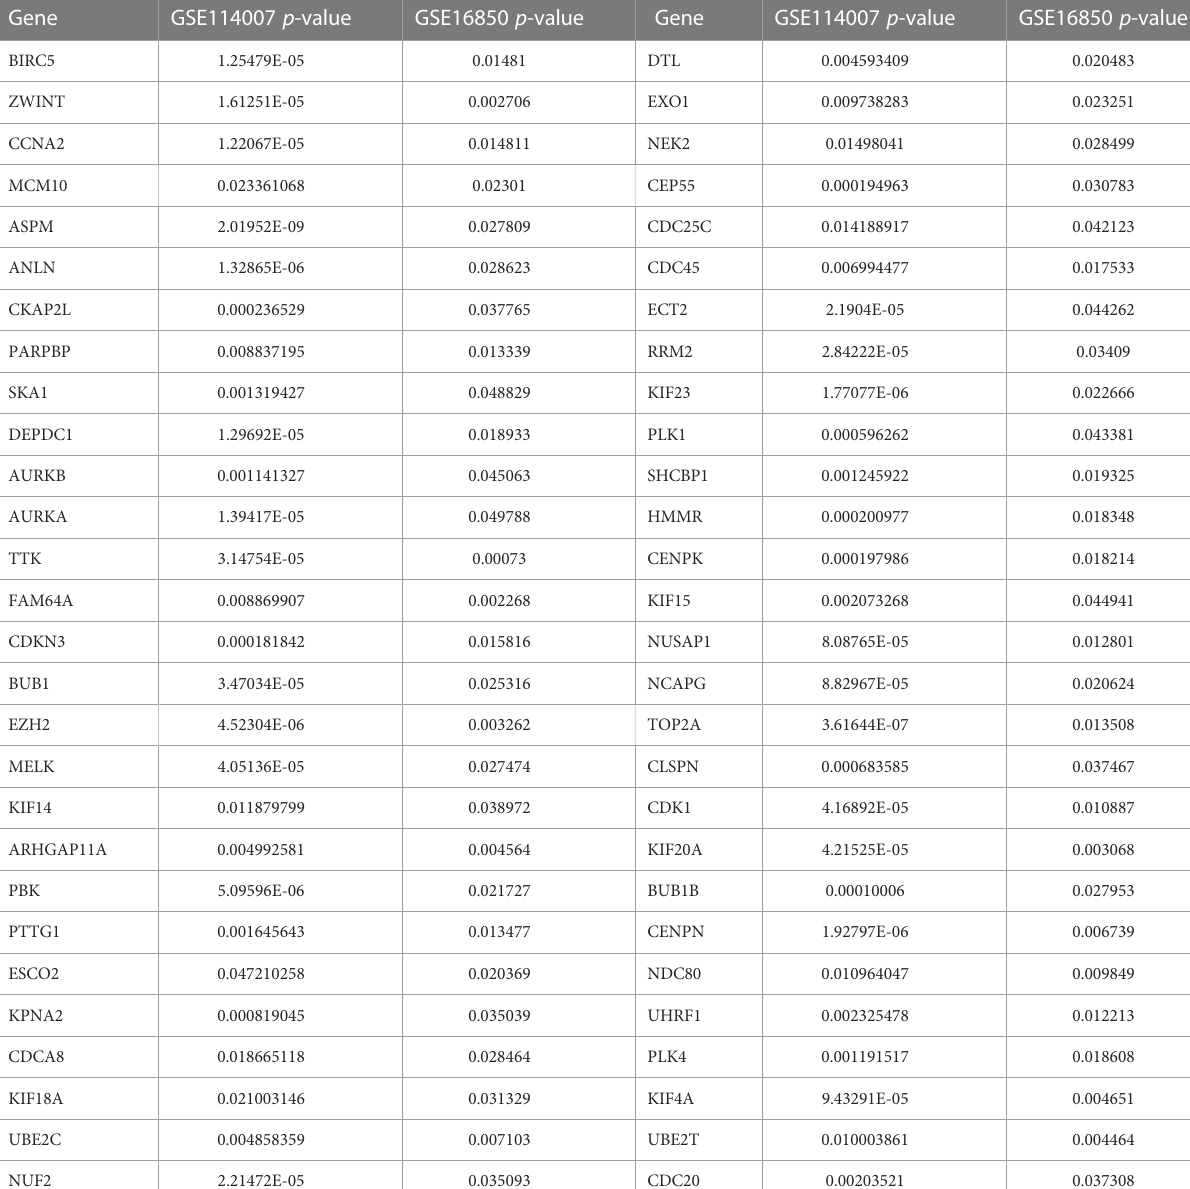
TABLE 2 Differentially expressed p -values of hub genes in the GSE114007 and GSE168505